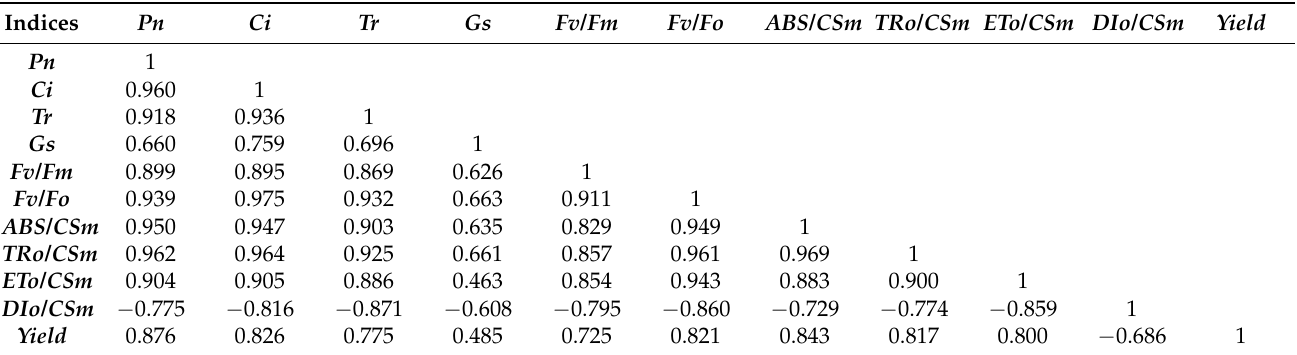
Table 5. Correlation analysis between plant physiological indicators and tomato